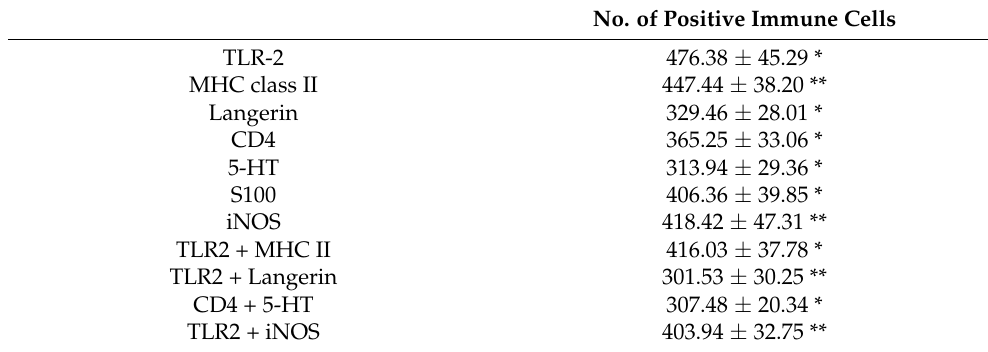
Figure 6. Section of the H. niloticus gut * immunofluorescence (* 40 × , scale bar 20 µ m). Numerous immune cells, which are densely organized, colocalize for iNOS and TLR2 (arrows) in the submucosa. The “Display profile” function highlights the colocalization. TL = transmitted light. Table 1. Statistical analysis data. (Mean values ± standard deviation) ( n =